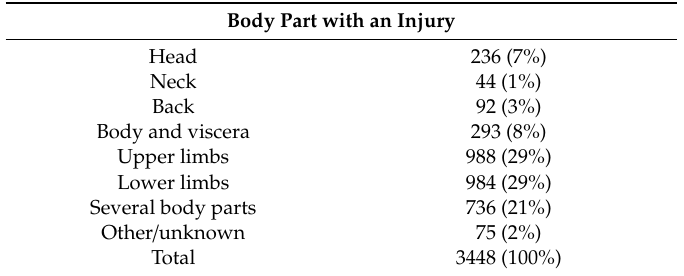
Table 4. The numbers and shares of injuries to di ff erent body